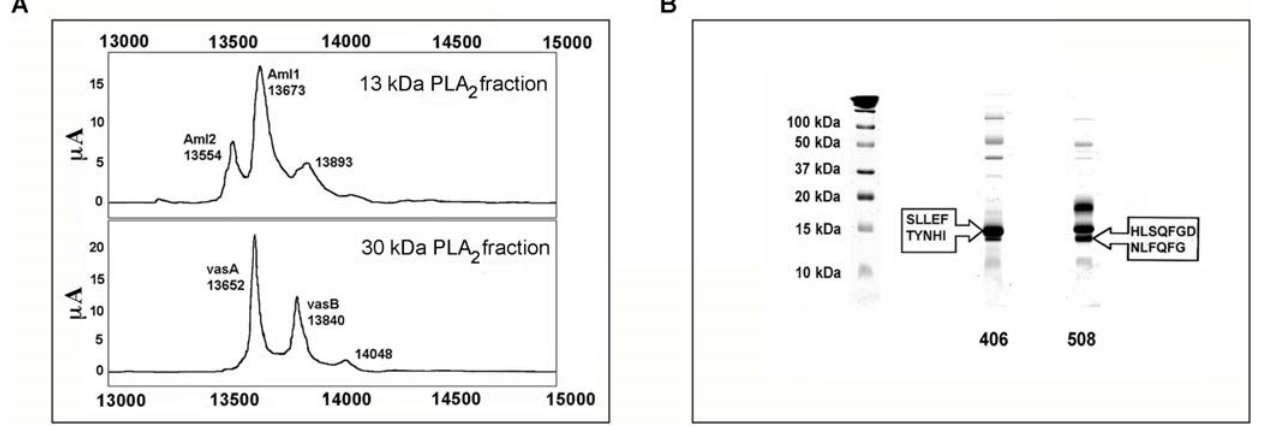
Figure 6. PLA 2 analysis by SELDI and SDS-PAGE. A) Vaa and Vaz PLA 2 fractions isolated from pooled venoms as shown in Figure 5 were spotted on WCX2 ProteinChips. Normalised mass (m/z) for each peak (in Daltons (Da)) is demonstrated on the X-axis, while intensity ( m A) is plotted on the Y-axis. B) Venoms 406 and 508 were separated by SDS-PAGE on a 20% homogeneous acrylamide gel under reducing conditions. N-terminal and internal sequences were determined as described in the Material and Methods